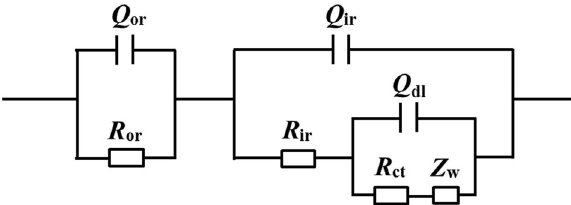
Fig. 6 Electrochemical equivalent circuit used for fi tting the EIS data. Q or and R or are the capacitance and resistance of the outer CPL, respectively; Q ir and R ir are the capacitance and resistance of the inner CPL, respectively; Q dl is the electric double layer capacitance; R ct is the charge transfer resistance; and Z w is the Warburg diffusion